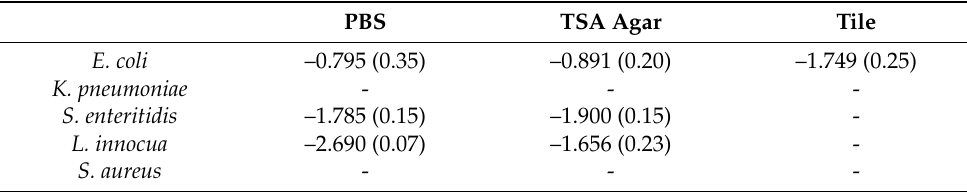
Table 2. Summary table of log reduction values depending on microorganisms at 9.0 mJ/cm 2 energy density (exposure time of 2 s).